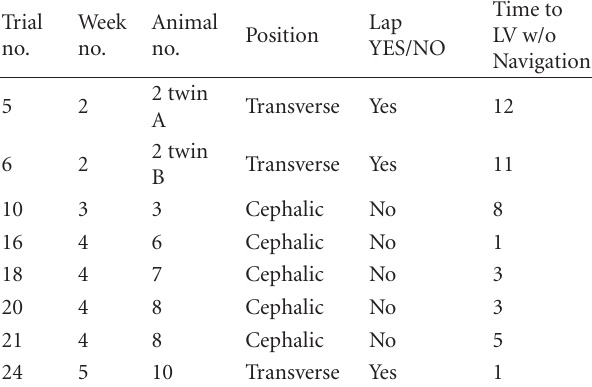
Table 1: Table summarizing trial number, week of the trial, animal number, fetal position, need for laparotomy, and the time required to navigate the needle to the correct position in the left